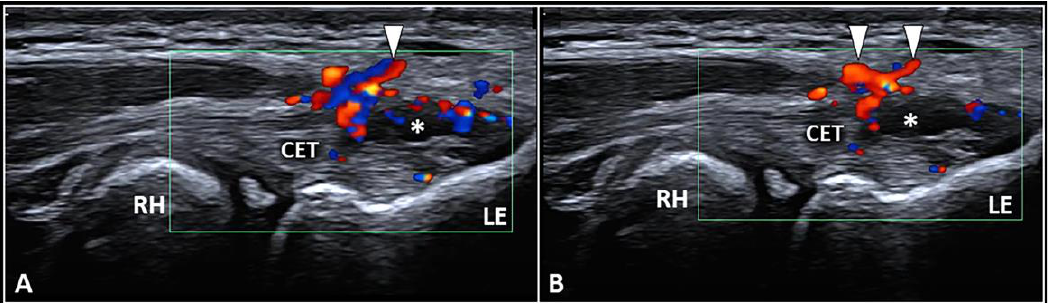
Figure 1. Ultrasound examination with color Doppler ( A , B ) clearly shows how the aberrant neo- vessels ( white arrowheads ) originating from the superficial vascular plexus of the subcutis pierce the forearm fascia invading the hypoechoic zone ( white asterisk ) of the CET related to insertional tendi- nosis. RH: radial head, LE: lateral epicondyle, CET: common extensor tendon.